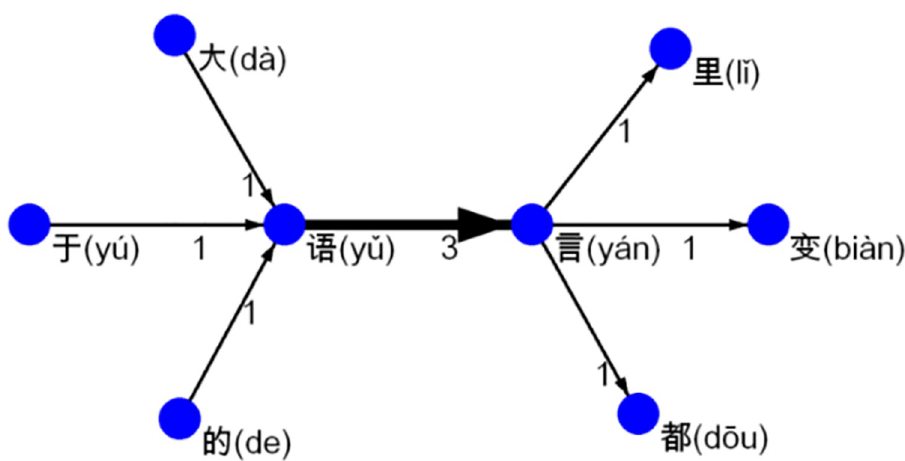
Fig 1. A network model of 语言 (yı¯ya´n, ‘language’) with its immediate context in the text of Example 1.